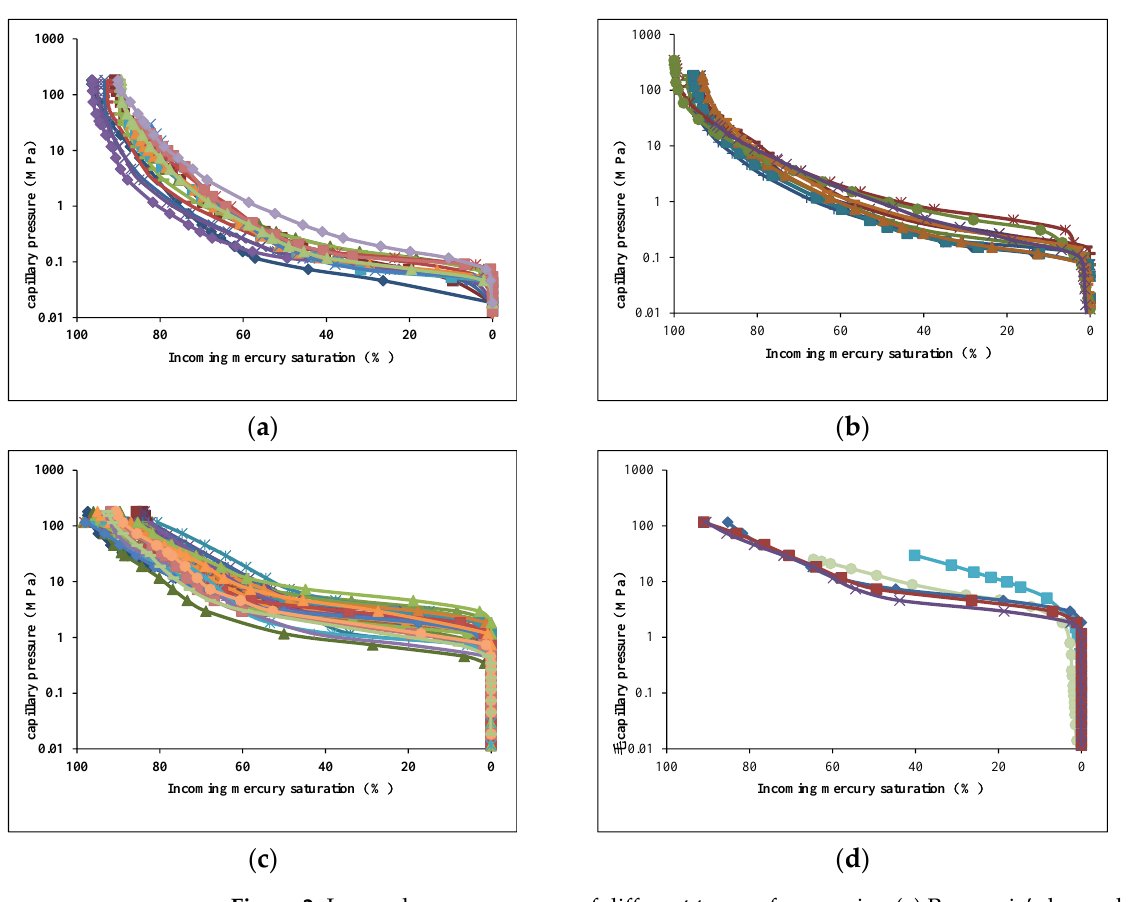
Figure 2. Layered mercury curves of different types of reservoirs. ( a ) Reservoir’s layered mercury curve of type I; ( b ) Reservoir ’s layered mercury curve of type II; ( c ) Reservoir ’s layered mercury curve of type III; ( d ) Reservoir ’s layered mercury curve of type IV. Table 1. The characteristic parameters of pore structure of different types of